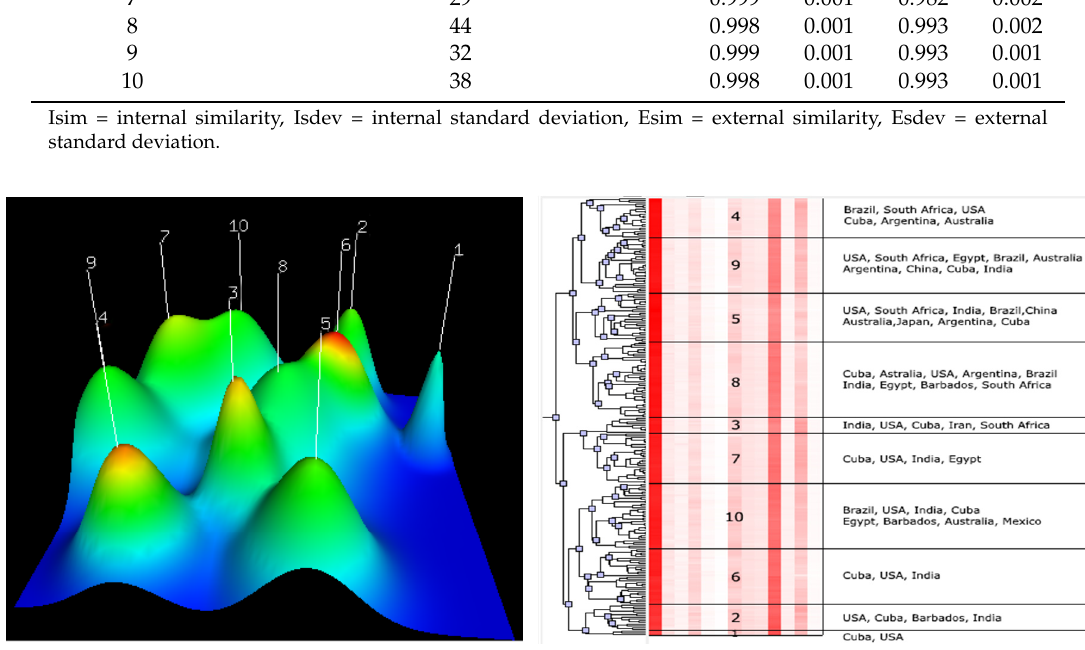
Figure 3. The mountain ( left ) and matrix ( right ) visualization of relationships among 10 clusters constructed in collection of sugarcane ( Saccharum spp.) in Khuzestan. The clustering analysis and visualization were performed using gCLUTO.